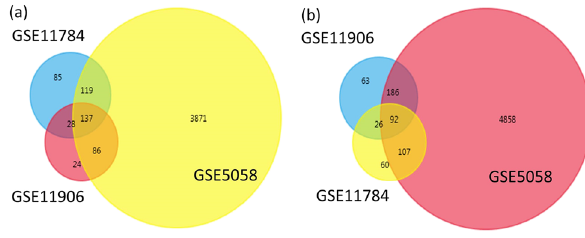
Figure 2: Venn diagrams with common DEGs of the GSE5058, GSE11784, and GSE11906 datasets. ( a ) Upregulated common DEGs; ( b ) downregulated common DEGs.